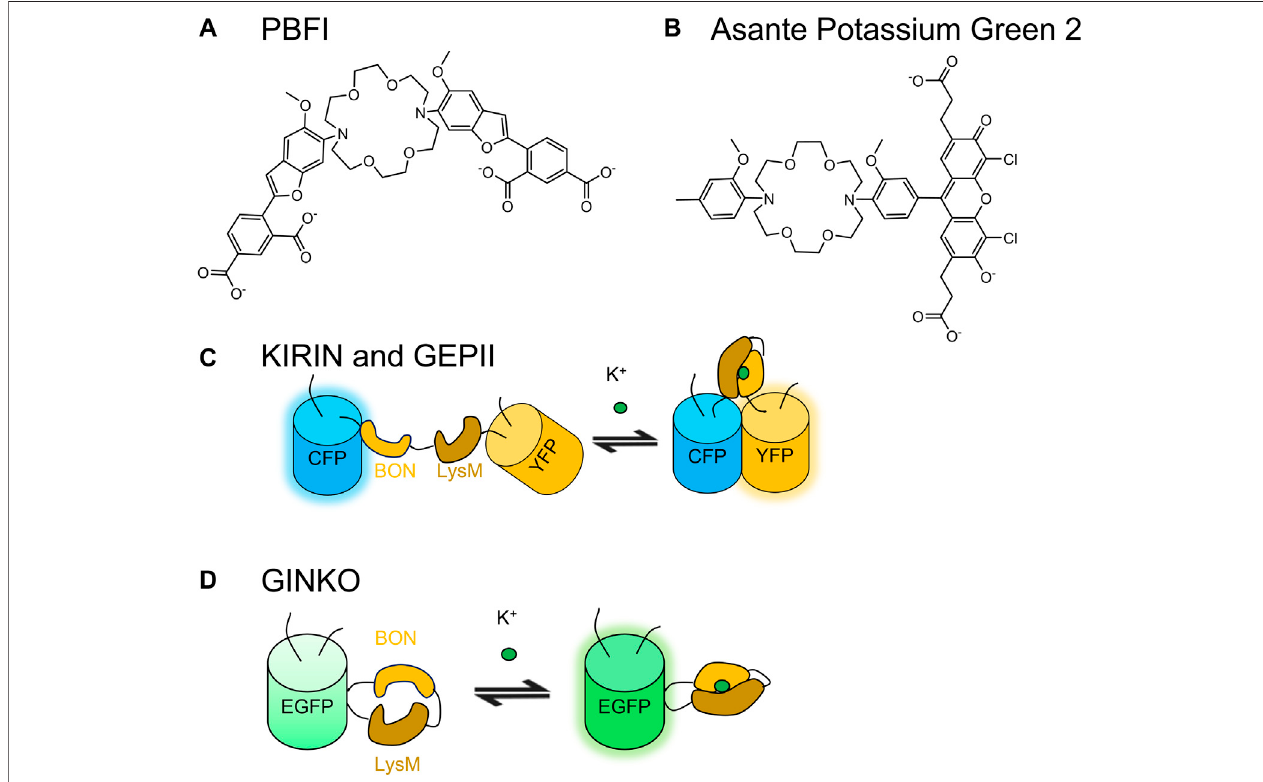
FIGURE5| Molecularstructures ofselected smallmolecule-based K + indicators(PBFI and Potassium Green2)and schematicrepresentations ofselectedGEKIs. Small molecule-based K + indicators (A) PBFI and (B) Asante Potassium Green 2 (APG-2) are based on 1, 10-diaza-4, 7, 13, 16-tetraoxacyclopentadecane (Minta and Tsien, 1989; Rimmele and Chatton, 2014). (C) FRET-based KIRIN and GEPII are based on Kbp that consists of a BON and a LysM domain (Ashraf et al., 2016; Shen et al., 2019). (D) GINKO1 and GINKO2 are based on Kbp and ncpEGFP (Shen et al., 2019; Wu et al., 2021).